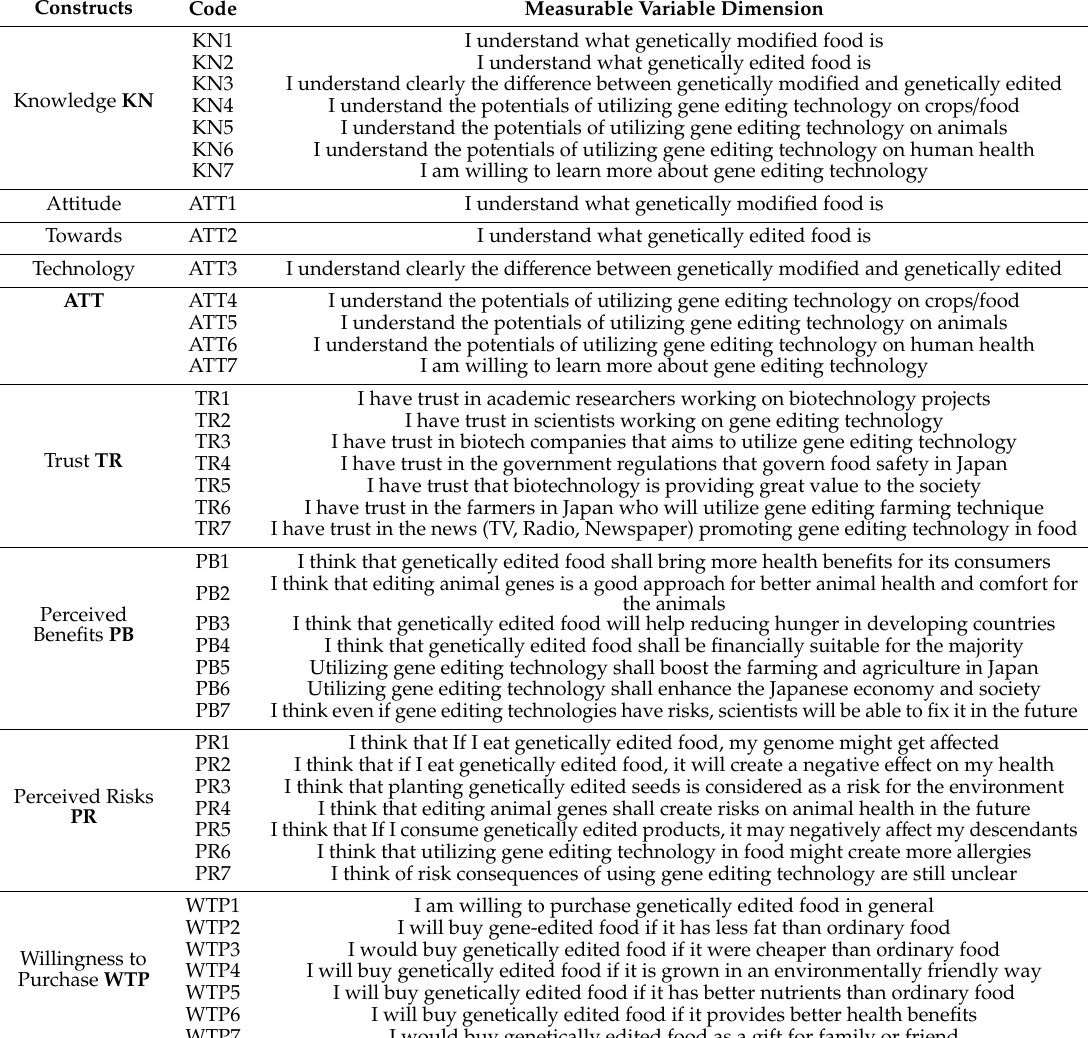
Table A1. Variables in the hypothetical